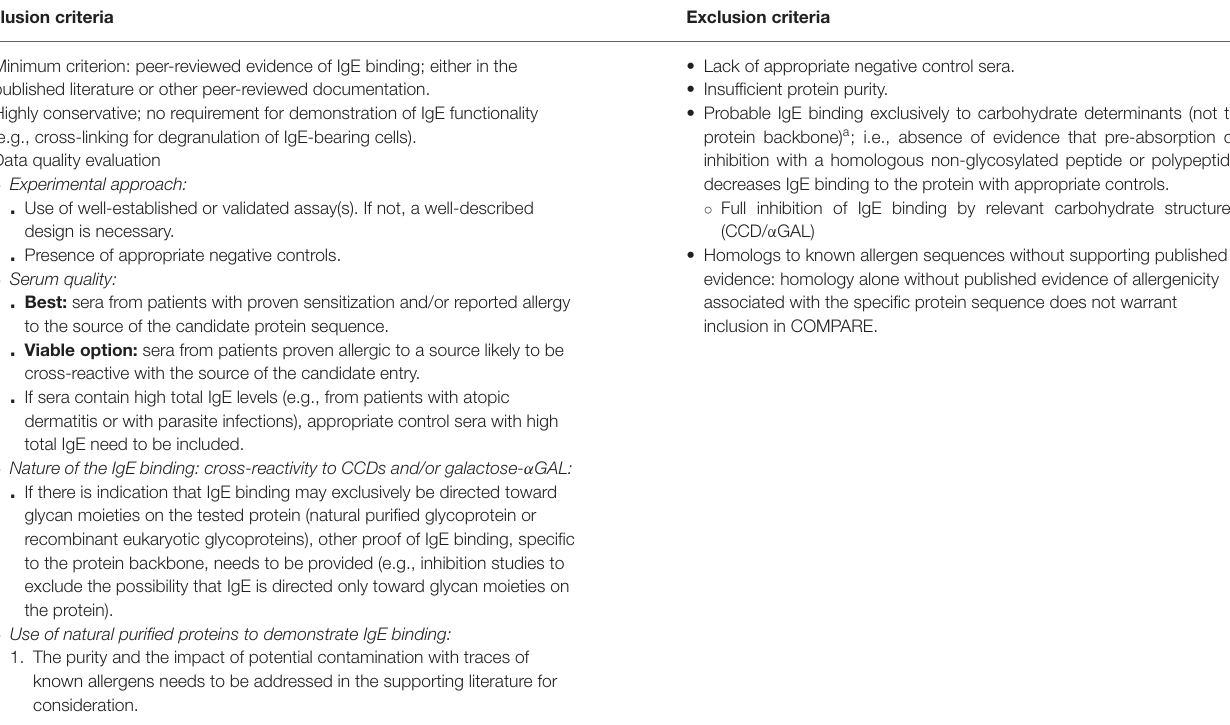
TABLE 2 | COMPARE peer review panel: scientific review decision process and inclusion/exclusion criteria defined by the experts in the independent panel. Inclusion criteria Exclusion